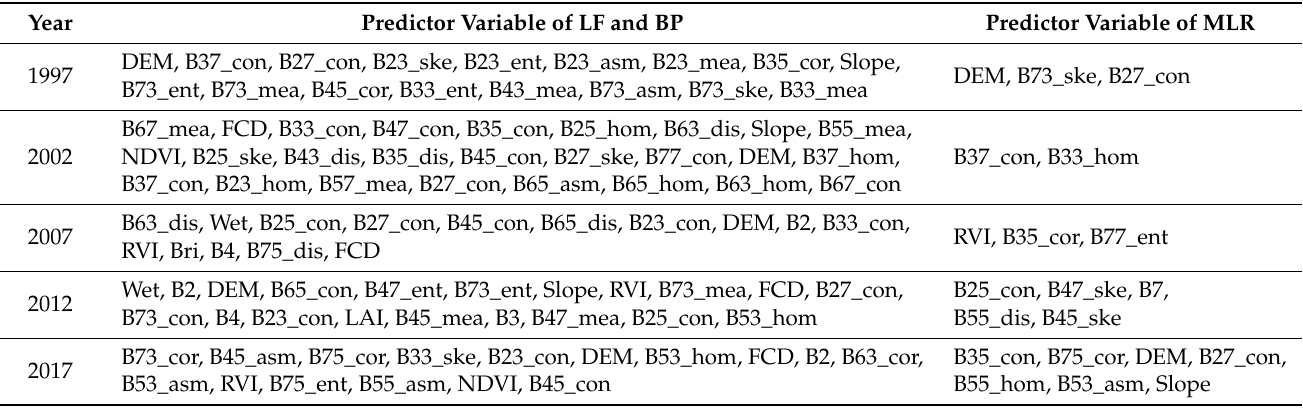
Table 4. The selected predictor variables for LF, BP neural network, and MLR models. Predictor Variable of LF and BP Predictor Variable of